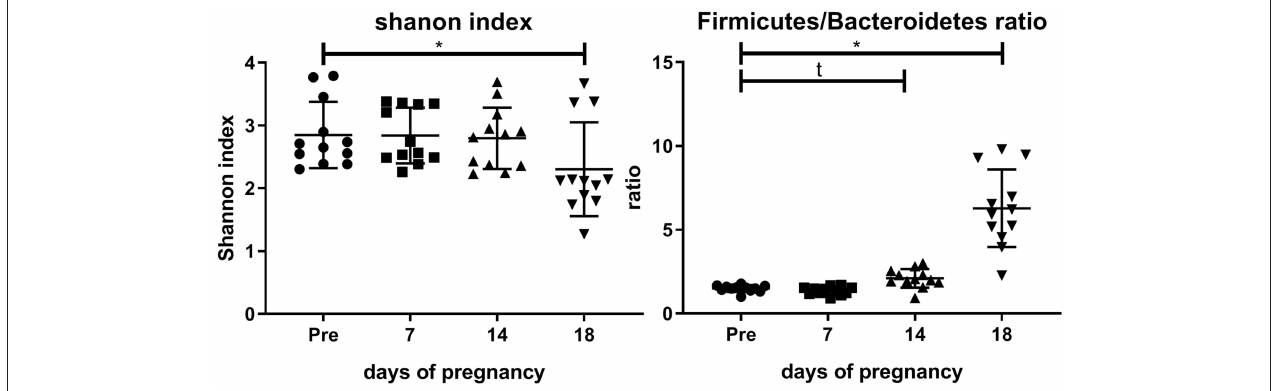
FIGURE 2 | Shannon index (left graph) and Firmicutes/Bacteroidetes ratio (right graph) in the feces of conventional mice measured pre-pregnancy (pre) and at days 7, 14, and 18 of pregnancy ( n = 10 at each day). *Significantly different from pre-pregnancy (Friedman’s test, followed by Dunn’s post-test, p < 0.05). t, significant trend